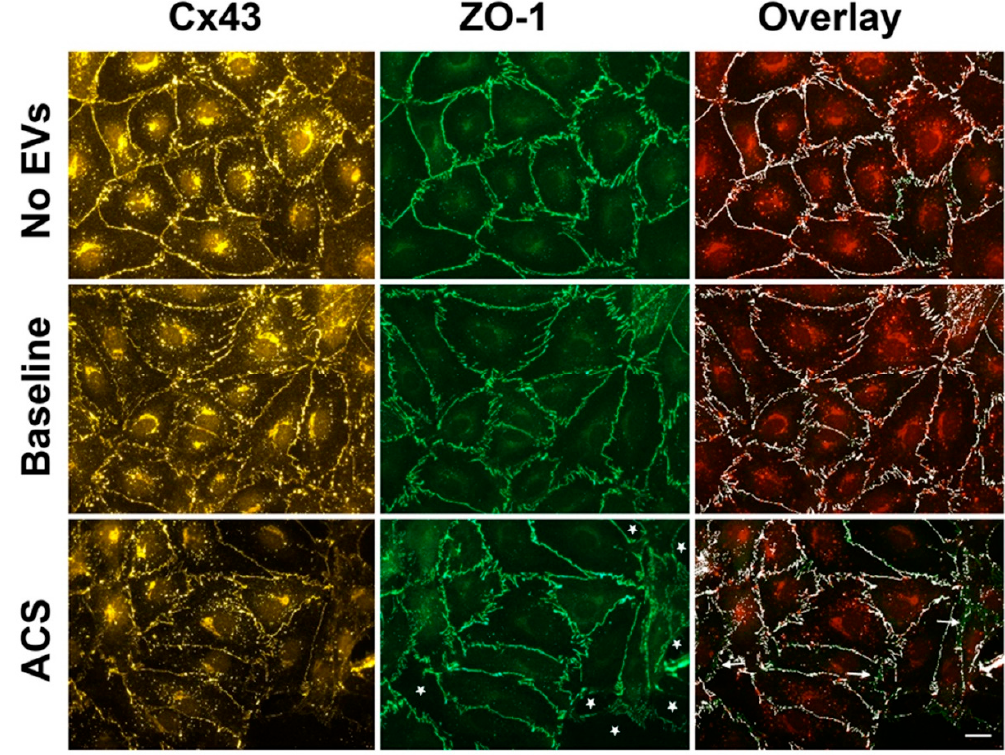
Figure 2. Localization of ZO-1, Cx43, and overlay in endothelial cells treated with EVs for 48 h. Representative photomicrographs are shown for HMVEC-D cells following 48 h treatment with no EVs, EVs from a subject with SCD at baseline, and EVs from the same subject at the beginning of an episode of ACS. Cx43 (left panels) and ZO-1 (middle panels) were detected by immunofluorescence. Right panels represent co-localization of Cx43 and ZO-1 (colocalized points are shown in white). Arrows indicate the regions along the membrane interfaces with poor overlay between Cx43 and ZO-1; green staining alone. The amount of co-localization at the membrane decreased in the cells treated with EVs from an ACS sample (18% less Cx43 immunoreactivity in areas that stained for ZO-1). White stars in the middle bottom panel indicate extracellular space in the ACS sample, showing damage to endothelial integrity caused by EVs from ACS patients. In the example shown, the monolayer disruption was 6.7%. Scale bar is 20 µm.